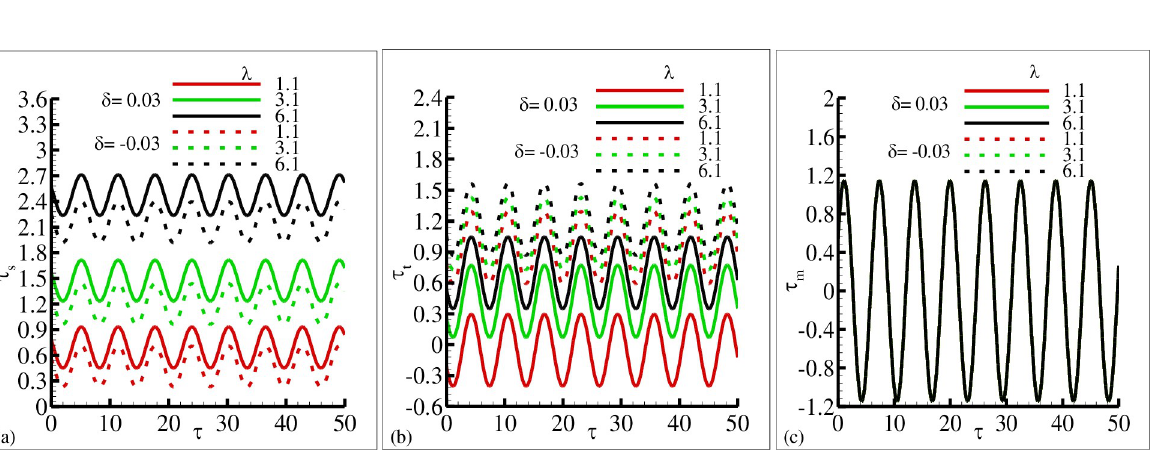
(b) q and (c) j for various values of λ = 1.1, 3.1, 6.1 for heat source δ = 0.03 and sink δ = − 0.03, where other w w w